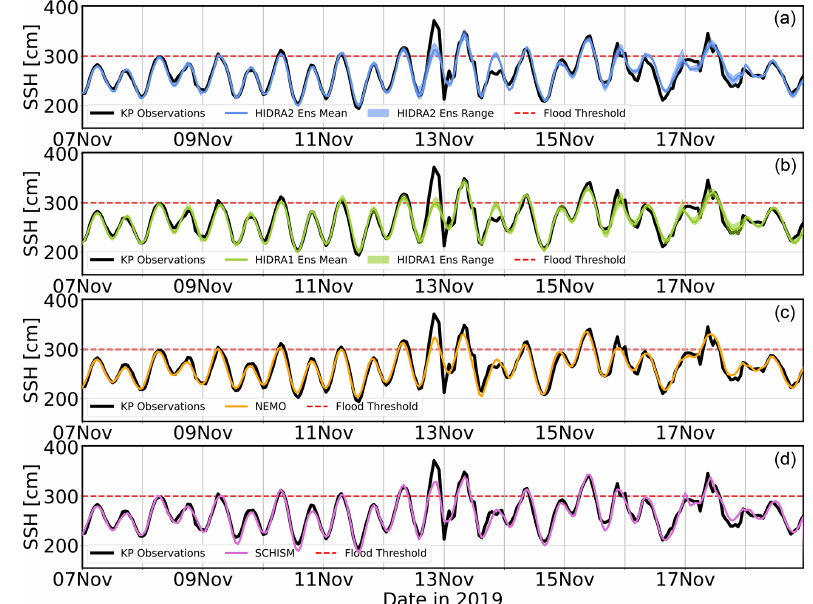
Figure 12. Comparison of the HIDRA2 ensemble (a) , HIDRA1 ensemble (b) , NEMO forecast run (c) and SCHISM reanalysis run (d) during the November 2019 flooding sequence in the northern Adriatic. Semi-transparent regions in (a) and (b) depict the minimum–maximum envelope of each HIDRA